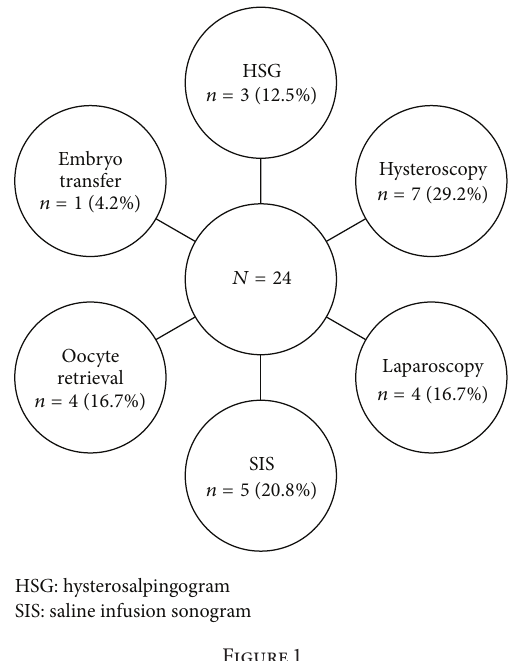
oocyte retrieval, 4 (16.7%); and embryo transfer, 1